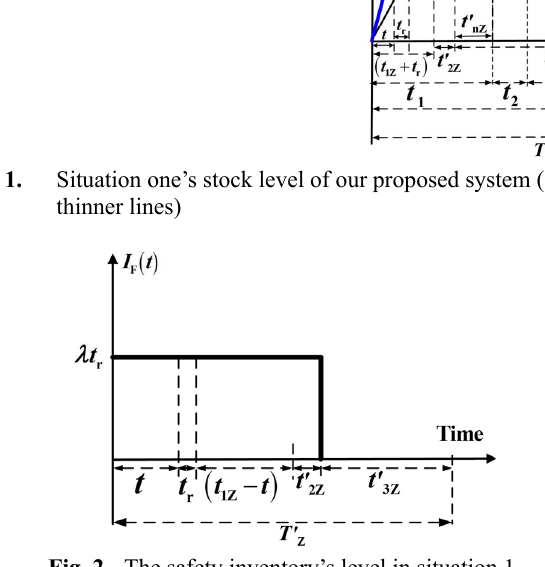
Fig. 2. The safety inventory’s level in situation 1 Fig. 3. The inventory level of defective products in